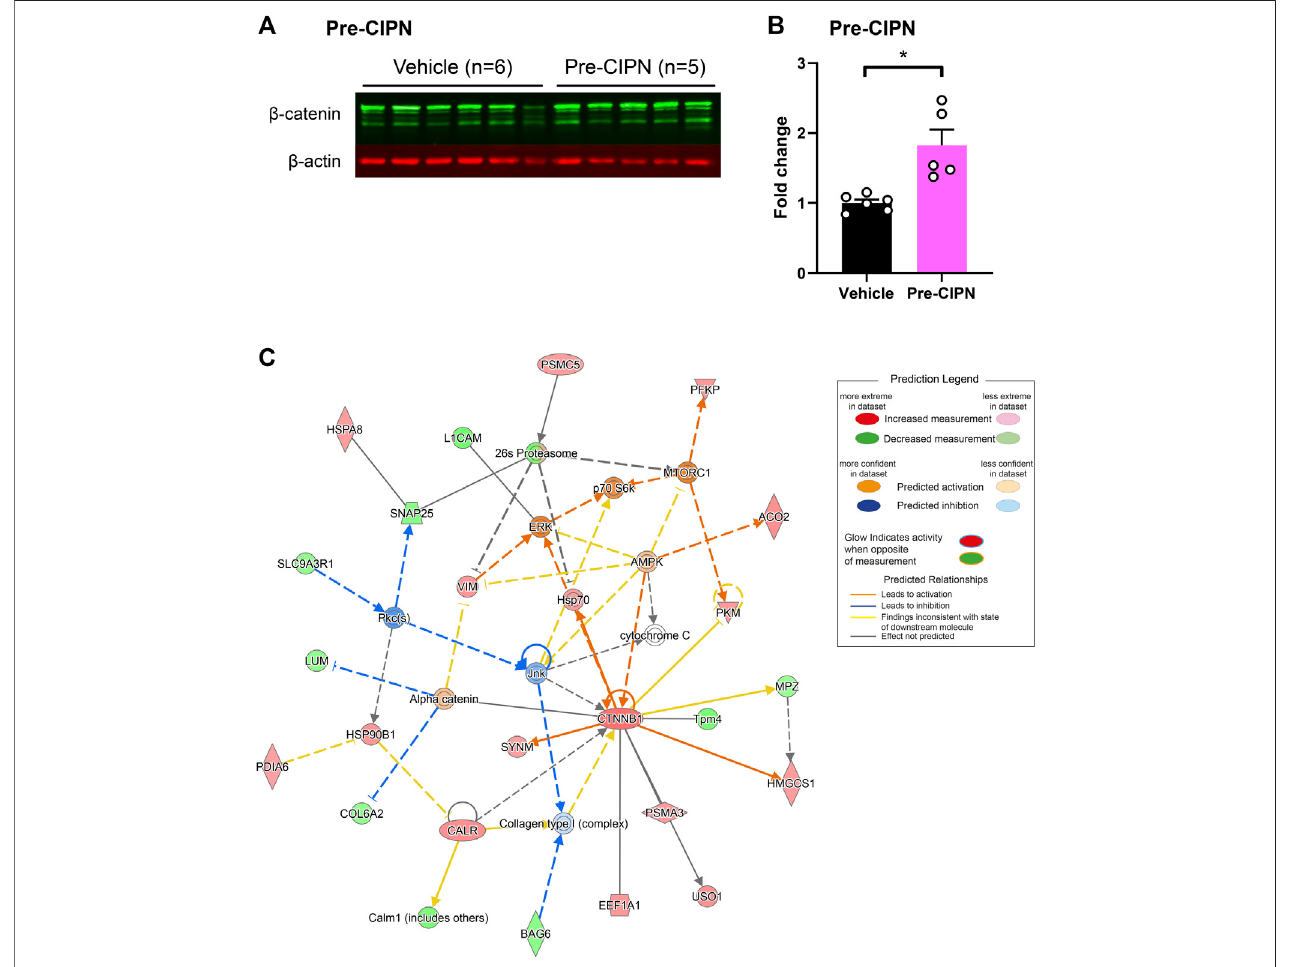
FIGURE5| Upregulationofß-catenin(CTNNB1)withpronouncedeffectsonassociatedproteinnetworks. (A) WesternBlotfor β -catenin(greenbands)and β -actin (red bands) in vehicle ( n = 6) and pre-CIPN ( n = 5). (B) Quanti fi cation of band intensity normalized to β -actin and expressed as fold change relative to control. Two-tailed unpaired t-test; p-value: 0.0036. (C) Protein network associated with CTNNB1 ( Supplementary Table S5 Network 5) and predicted activity analysis by IPA.